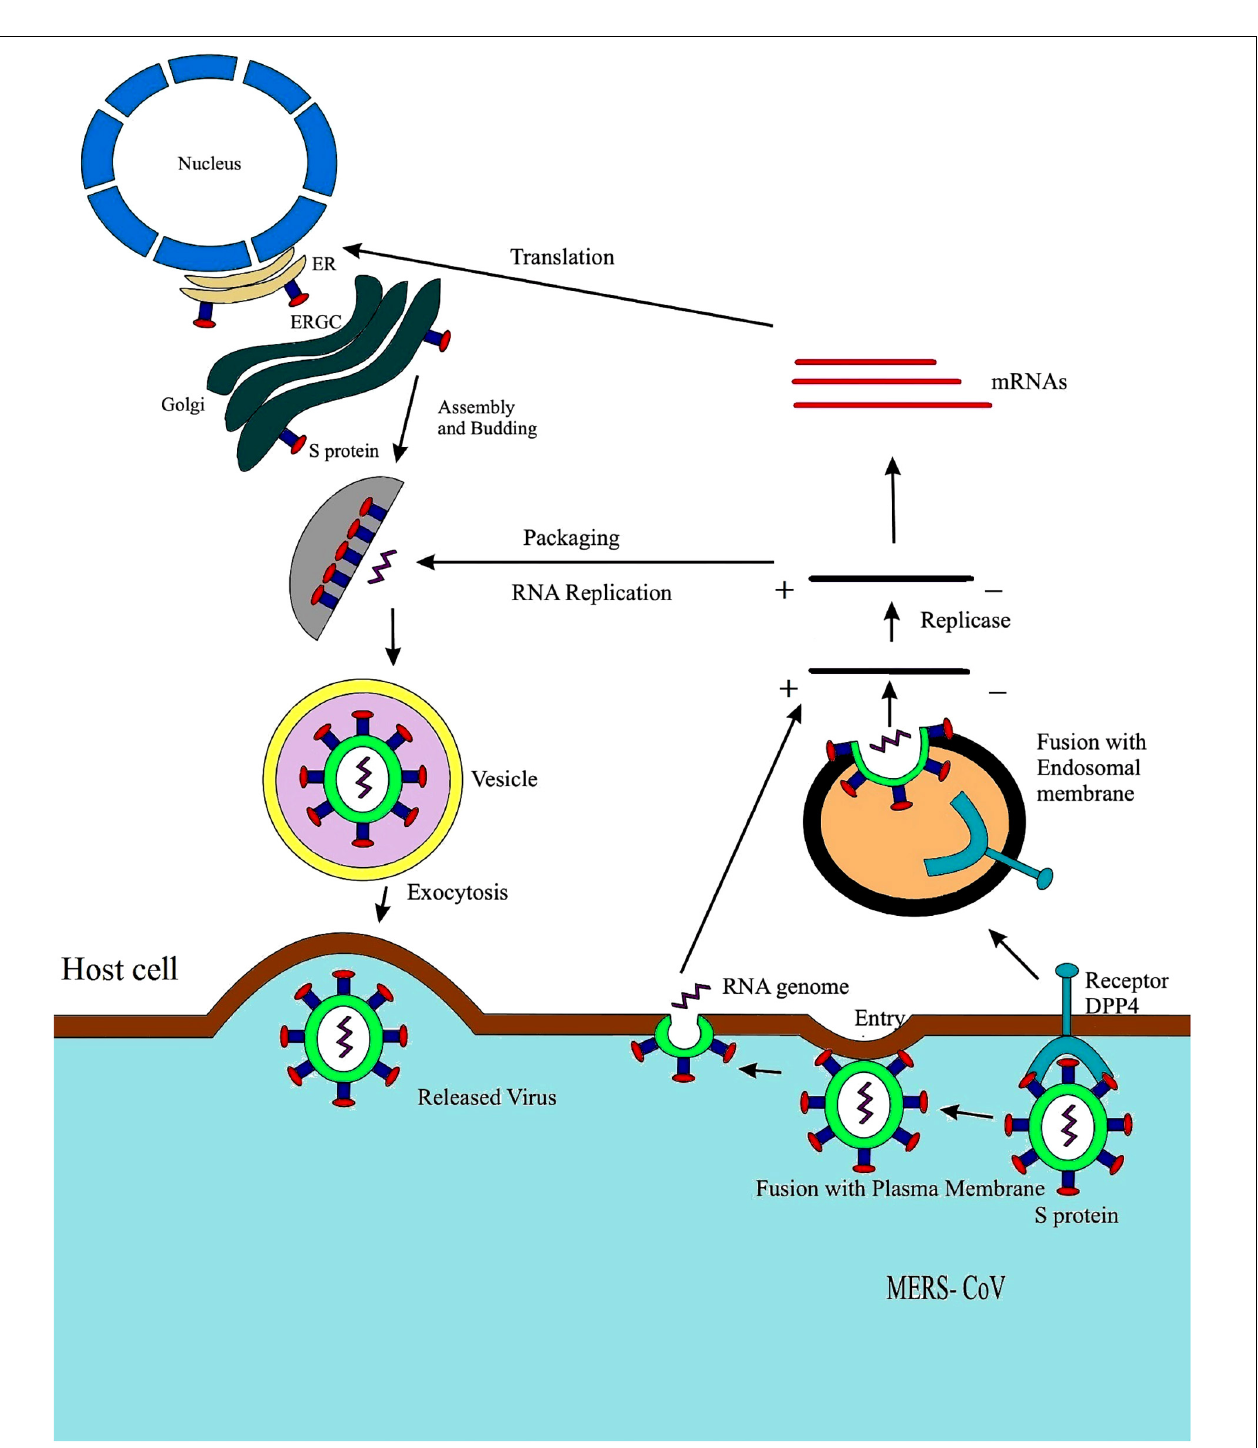
FIGURE 2 | Life cycle of MERS-CoV displaying fusion with plasma membrane. The fusion of S protein to the plasma membrane of host cell, formation of a double membrane vesicle in the host cell, eventually releasing the RNA enclosed in the nucleocapsid followed by genome transcription. The viral RNA undergoes replication and transcription followed by the 4, 5, and 6 RNA synthesis and translation; the endoplasmic reticulum aids the assembly and packaging of virus particle forming a complete double membrane vesicle and lastly through exocytosis and MERS-CoV is released out of the host cell (Du et al., 2009).